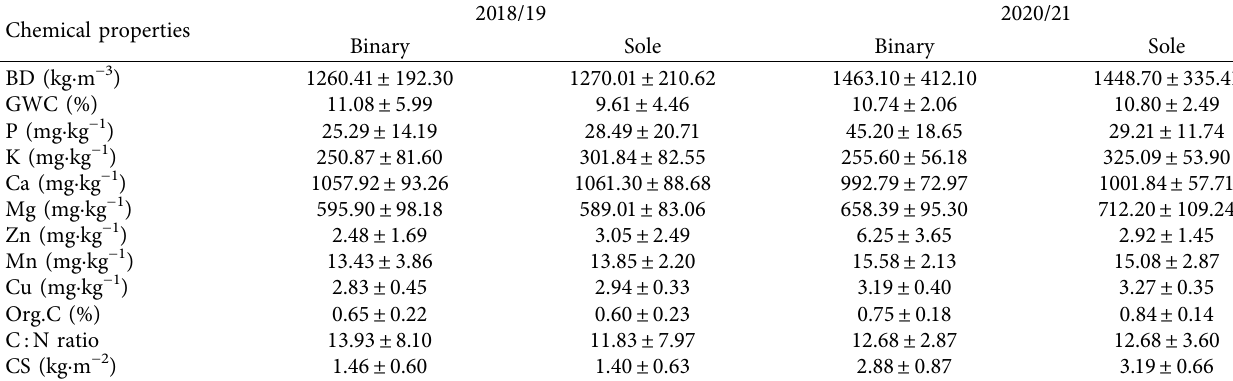
Table 1: Bulk density (BD), gravimetirc water content (GWC), and soil chemical properties from Syferkuil collected at the end of 2018/19 and 2020/21 cropping seasons.